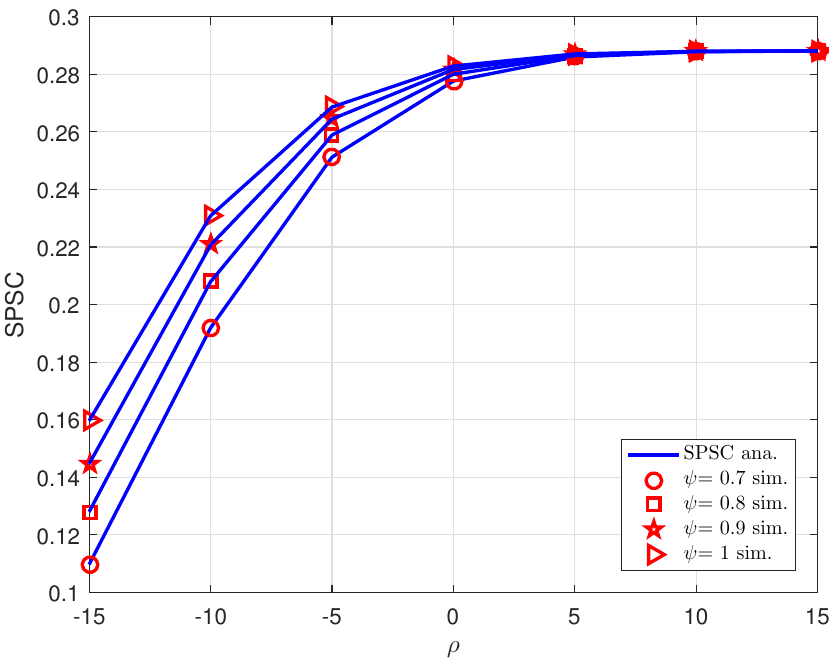
Figure 12. SPSC versus ρ for different ψ = α .